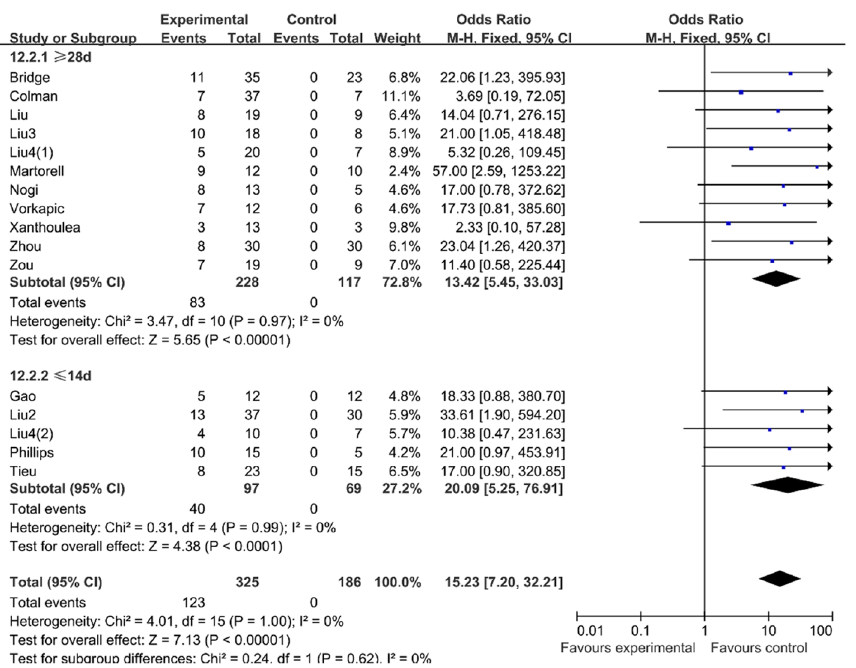
Table 7. In the vehicle group, the success rate of the mice challenged with AngII longer than 28 days decreased compared with the mice challenged with AngII less than 14